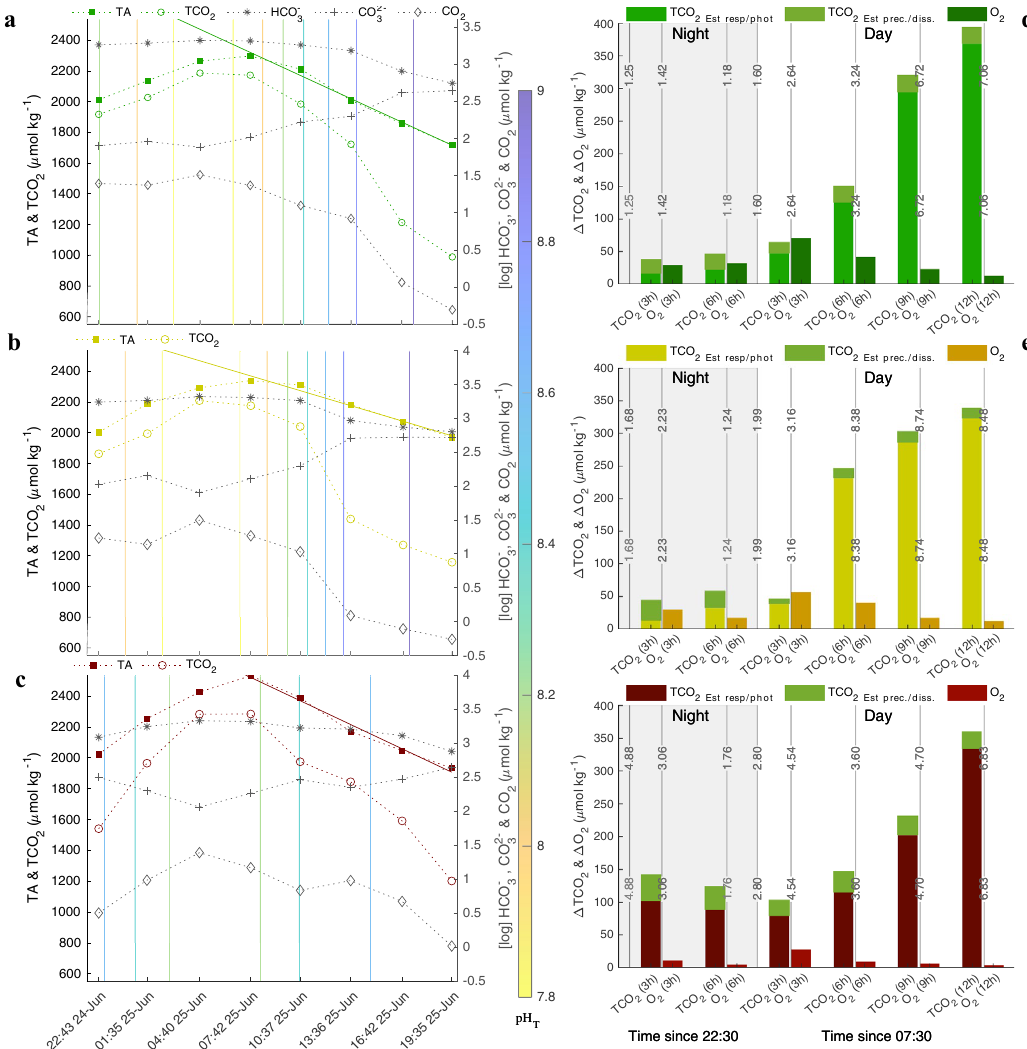
Figure 2. Alkalinity and TCO 2 (left y-axis) during 21 h emersion sampling period for dense grass ( a ), patchy grass ( b ), and no grass ( c ) pools. The log concentration of CO 2 , HCO 3 - , and CO 3 2- are marked as grey on the right y-axis with colored pH T isoclines. Absolute values of ΔTCO 2 and ΔO 2 during same emersion period where the total ΔTCO 2 was estimated based on proportion of change due to biological respiration/photosynthesis or CaCO 3 precipitation/dissolution for dense grass ( d ), patchy grass ( e ), and no grass ( f ). Isoclines are Ω arg . Note: The NG pool during this period began to experience increased salinity due to evaporation reducing confidence in the displayed